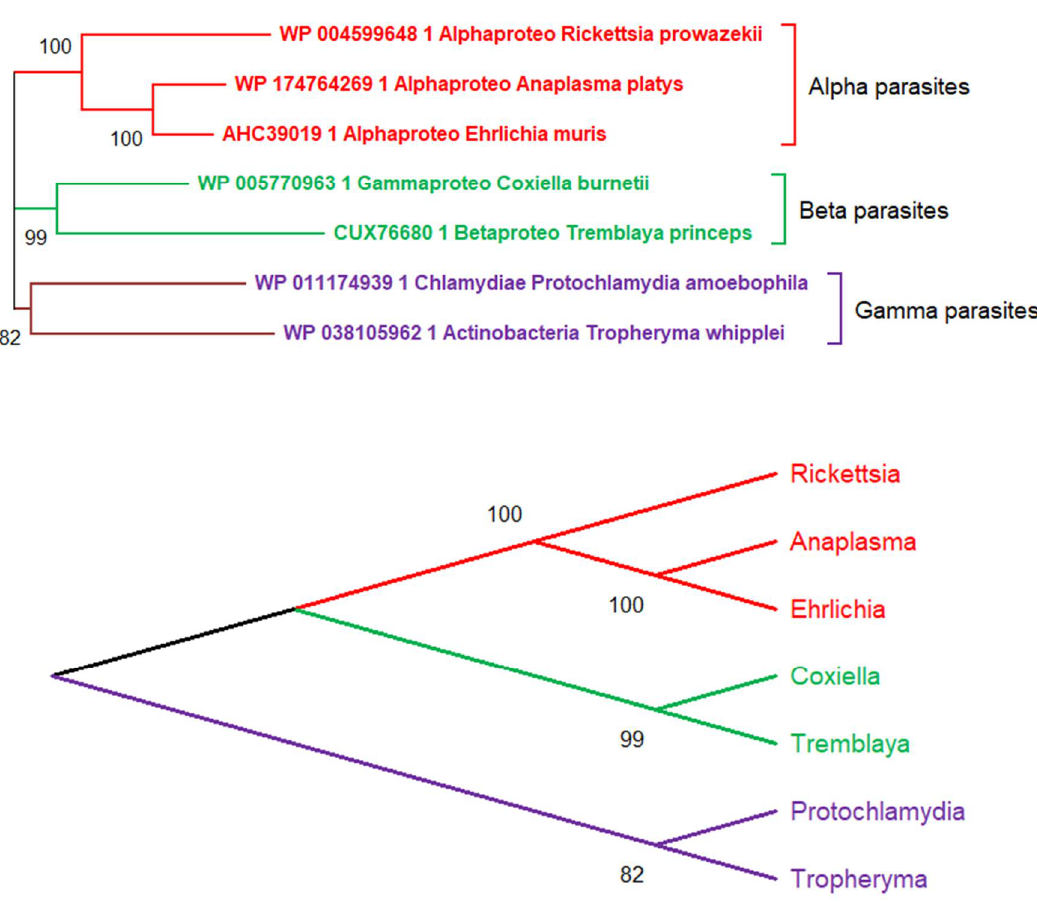
Figure 1. Erroneous phylogenetic relationships between seven obligate intracellular parasitic bacteria. Top : The neighbor-joining tree was generated from 1014 conserved sites in the multiple alignment of their DNA polymerase alpha subunits using the JTT substitution matrix. The protein NCBI identifiers are indicated. In absence of free-living bacterial relatives, the tree erroneously suggests (with a strong statistical support) the existence of 3 separate “parasite families” emerging from 3 distinct evolutionary branches (Alpha, Beta, Gamma). Bottom : Using a di ff erent representation, the tree topology (inherent to the tree-building algorithm) can be interpreted as supporting the existence of an ancestral obligate parasite from which all three families of extant parasites derived. The true evolutionary history of these parasitic bacteria is shown in Figure